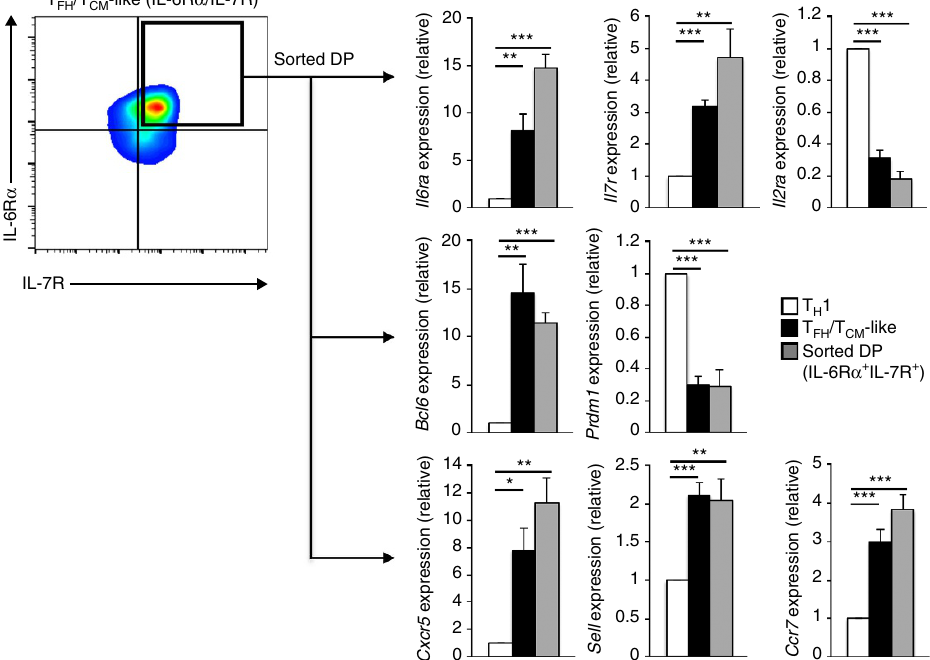
Figure 4 | Sorted IL-6R a þ IL-7R þ double-positive (DP) cells dually express T FH - and T CM -like gene programs. Droplet digital PCR analysis was used to examine expression of T H 1-, T FH - and T CM -associated genes. IL-6R a þ IL-7R þ double-positive cells were sorted and their expression profiles were compared with that of T H 1 (High IL-2) and T FH /T CM -like (Low IL-2) cells. Data were normalized to Rps18 and are represented as fold change in expression relative